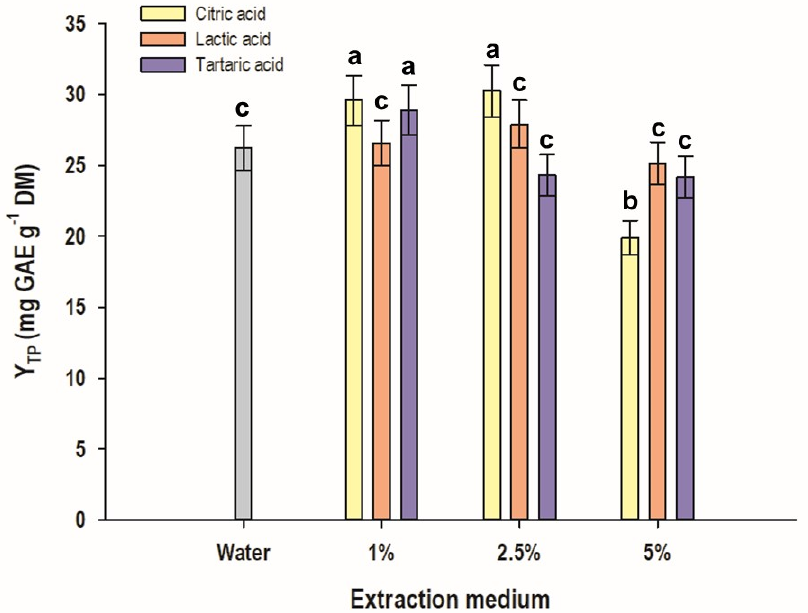
Figure 5. The bar plot presenting the effect of various acids and their concentration on Y TP . The extractions were performed at 55 °C, for 60 min, under stirring at 500 rpm. The bar denoted with different letters represent statistically different values ( p < 0.05).